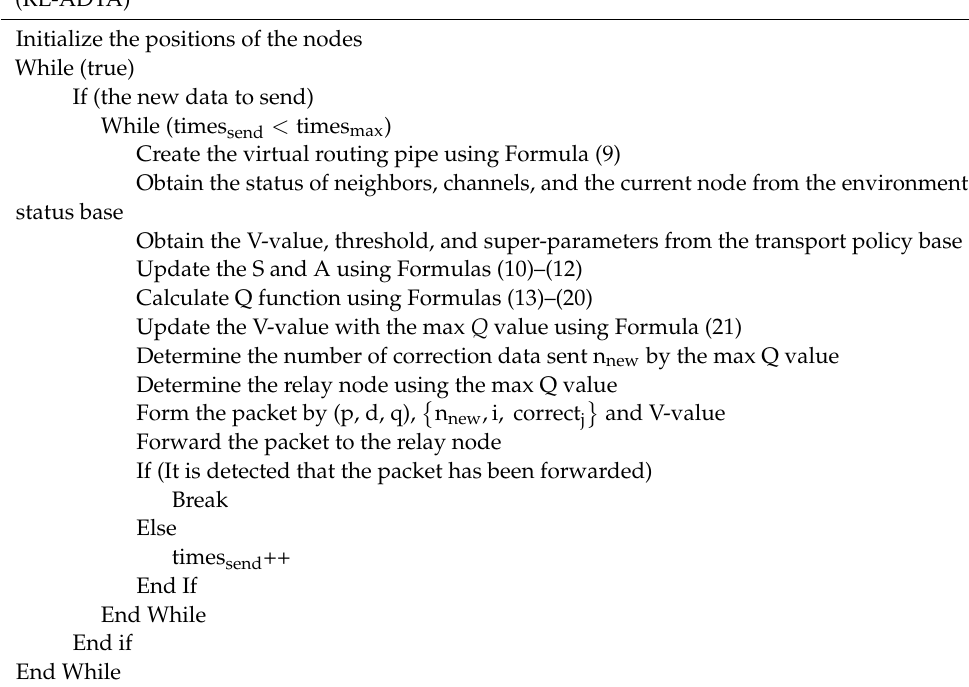
Algorithm 2 Adaptive Data Transmission Algorithm Based on Reinforcement